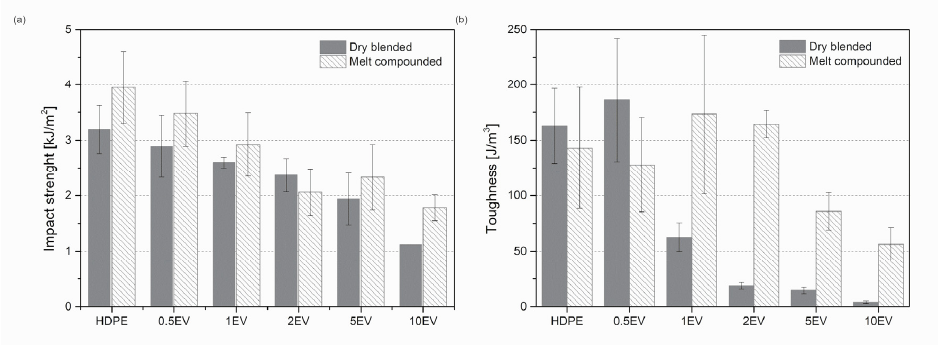
Figure 9. The impact strength for samples from the Charpy impact ( a ) test and measured toughness ( b ).